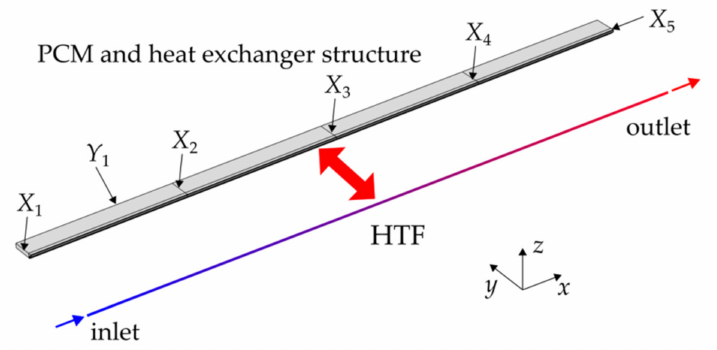
Figure 9. Three-dimensional (3D) simulation domain for PCM and heat exchanger structure together with 1D HTF domain. Surfaces X 1 to X 5 are implemented for the determination of convection. The surfaces are evenly distributed along the x